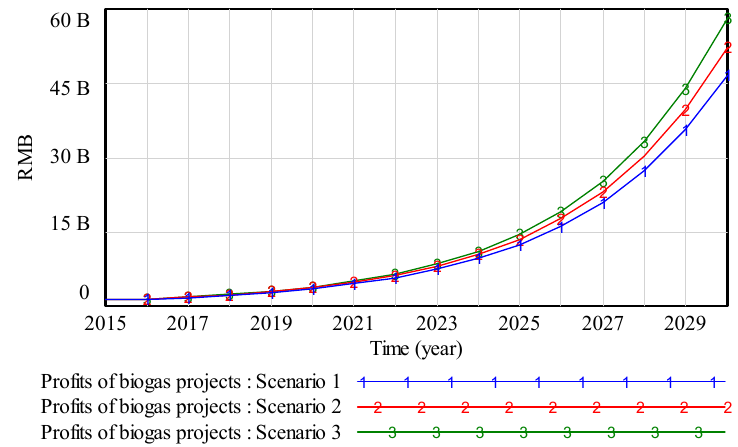
Figure 5. The profits of biogas Figure 5. The pro fi ts of biogas projects.